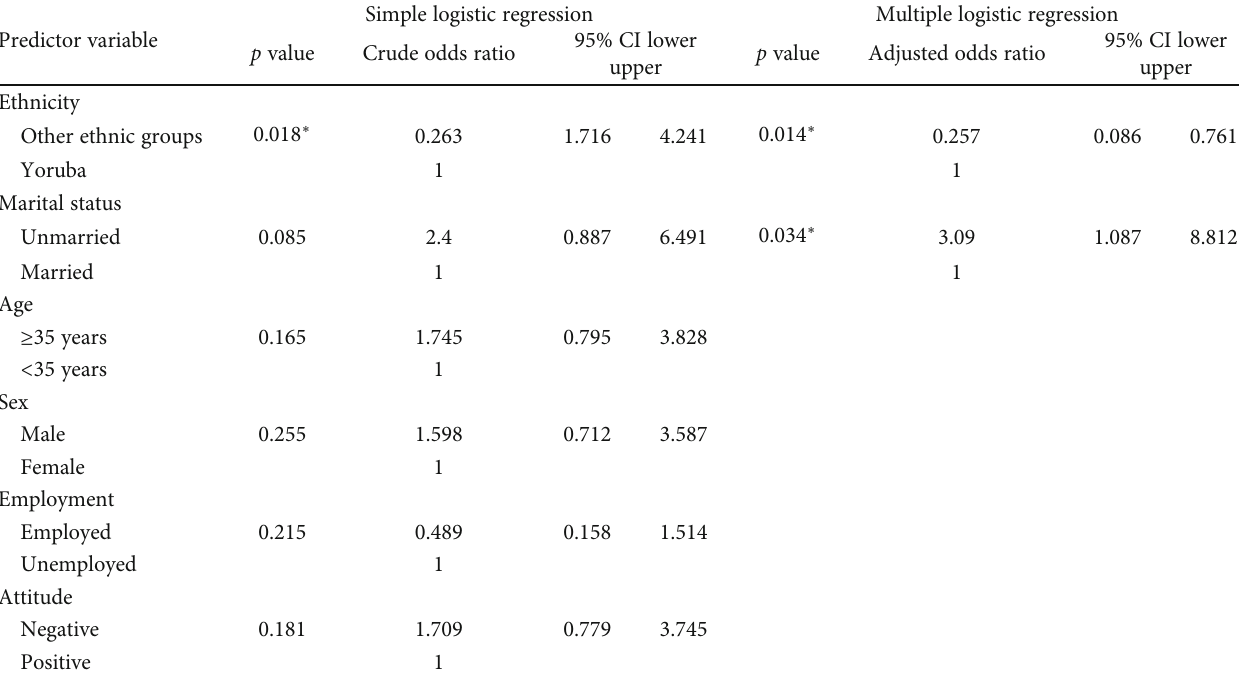
Table 9: Simple and multiple logistic regressions of TB-associated stigma and associated factor in rural communities. Predictor variable